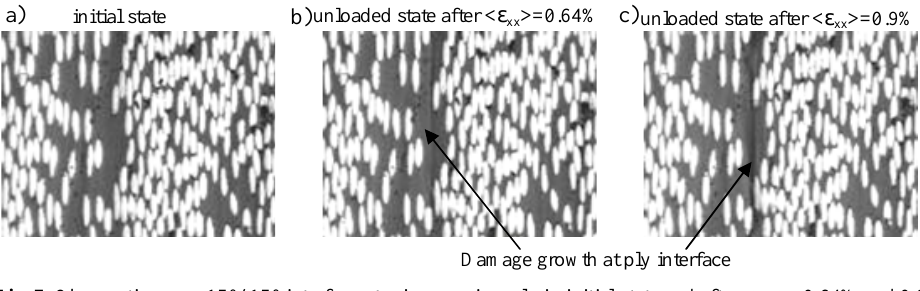
Fig. 6. Variation of m( e xz ) at the first interface as a function of < e xx > in [(15/-15) 2 ] s pure-UD-HS samples Images with higher magnification have also been taken at each loading and unloading steps to localize the origin of such residual strains. Fig 7, comparing images taken at unloaded state after applying different tensile strains < e >, shows local damages which grow at ply interface. xx